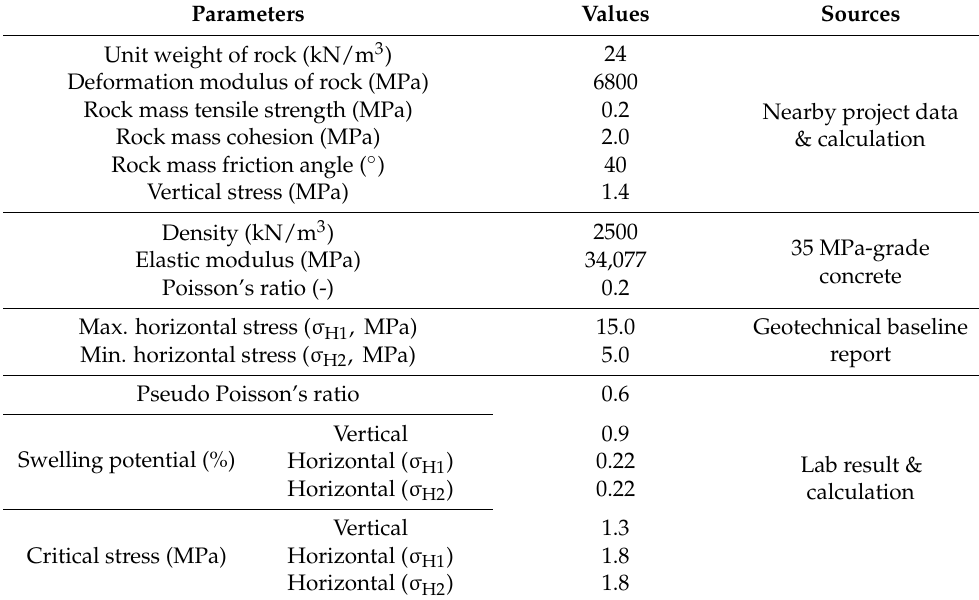
Table 5. Input parameters for the numerical